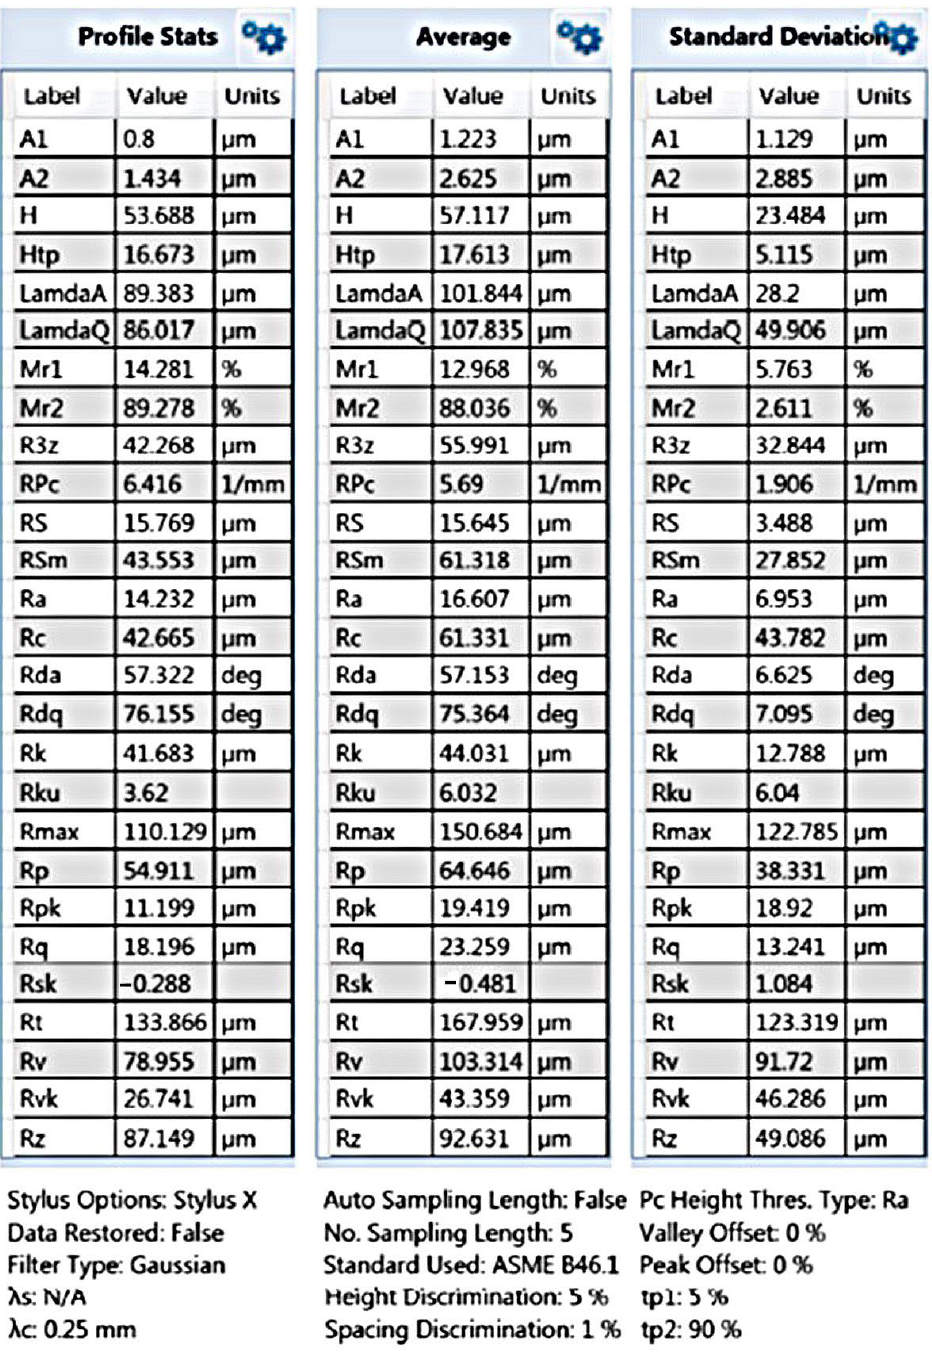
Figure 9. The results of measuring the thread quality before thermal pulse processing.